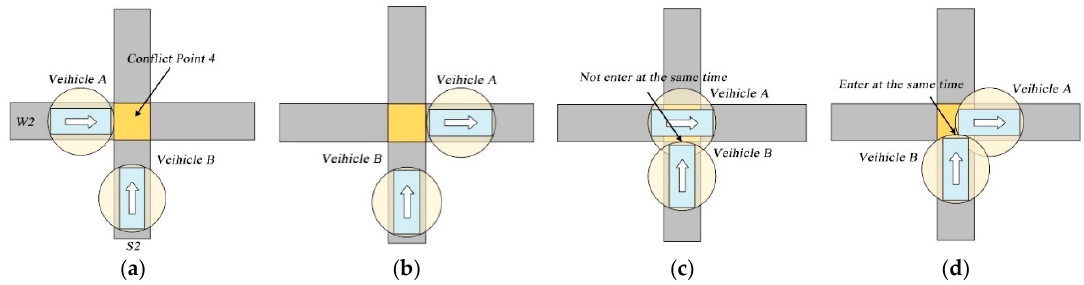
Figure 7. State of occupation. ( a ) Start of occupation; ( b ) end of occupation; ( c ) collision-free; ( d ) collision.